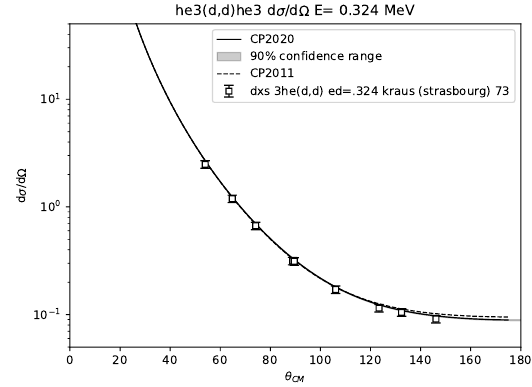
Figure 1. Confidence ellipse determined near the minimum of the function χ 2 ( ˆ p ) . EDA